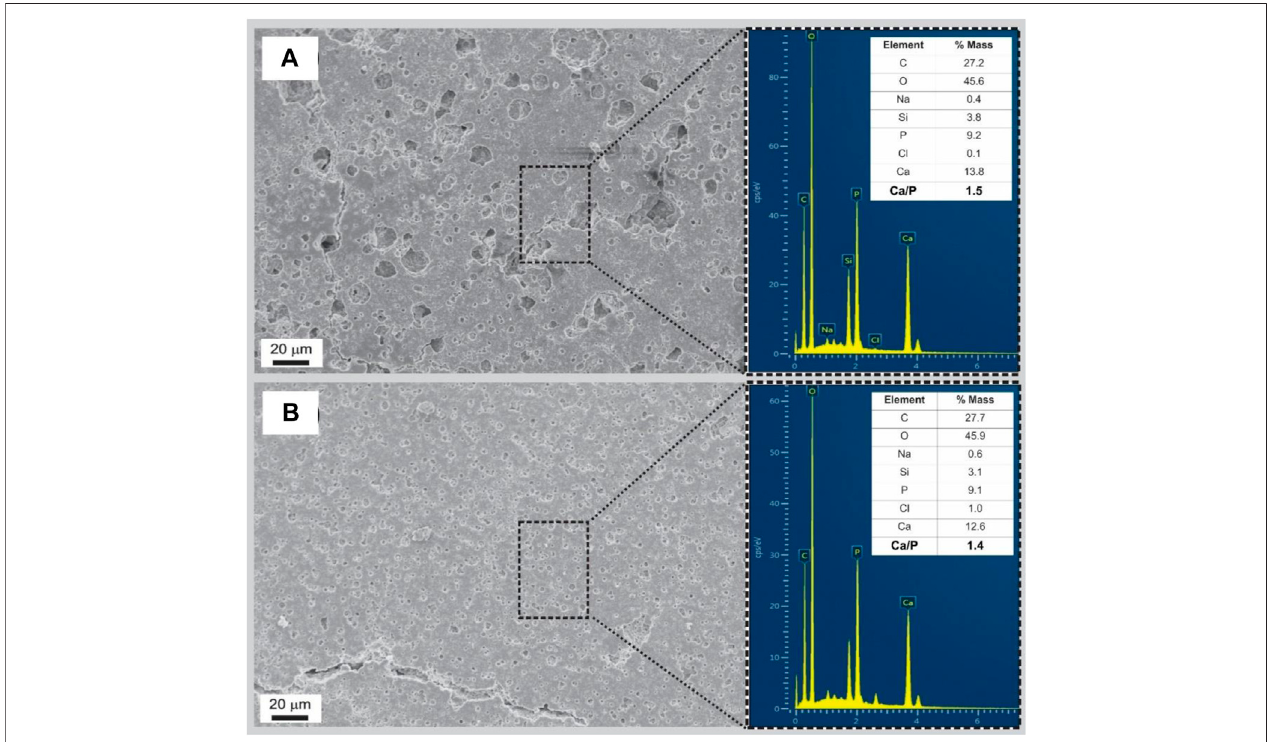
FIGURE 10 | SEM micrographs (1,000x) and EDX spectra of coatings after immersion in SBF solution during (A) 7 days and (B) 28 days.